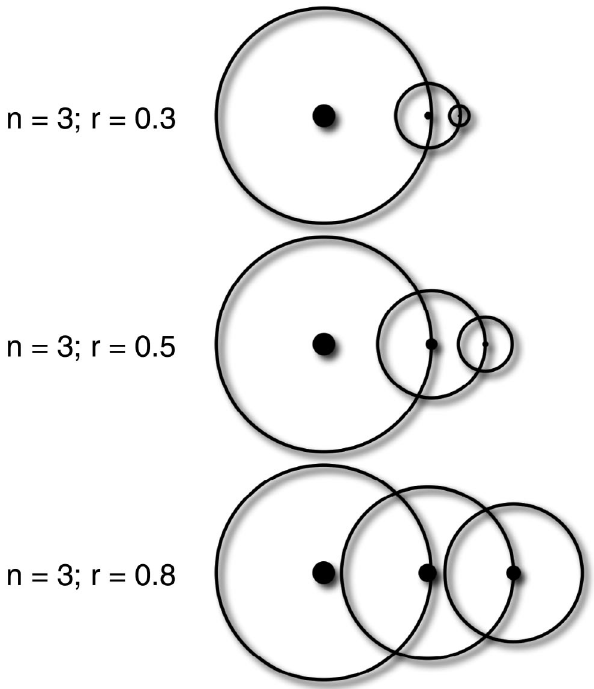
FIG. 1. The creation of an emitter in the point charge model for n (cid:2) 3 and various values of r . The circles are the equipo- tential lines of their center charge only: the total equipotential surface is created by all the point charges and is therefore slightly